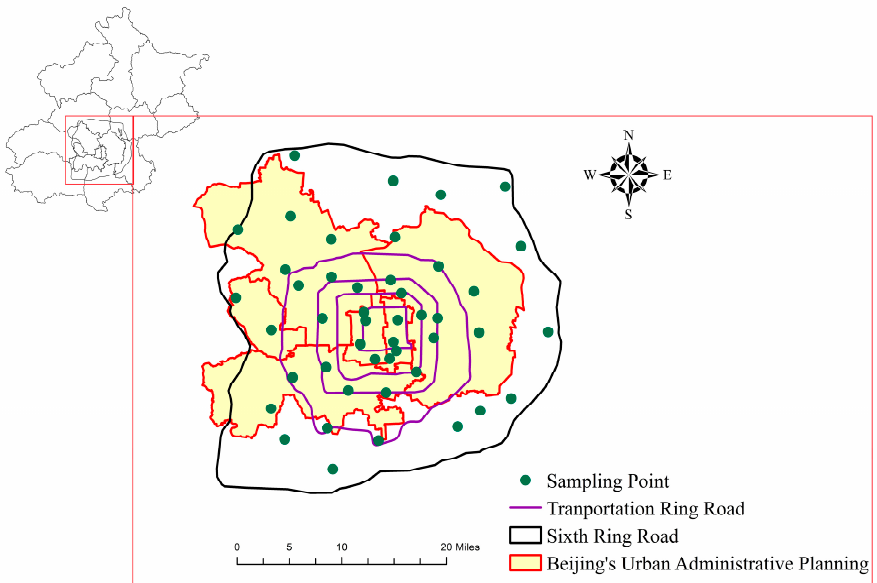
Figure 1. Map showing the distribution of sampling sites.